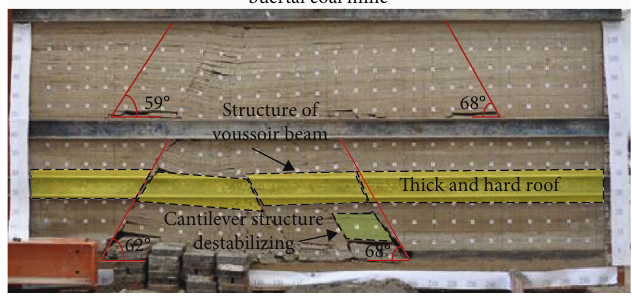
Figure 10: Results of physical simulation